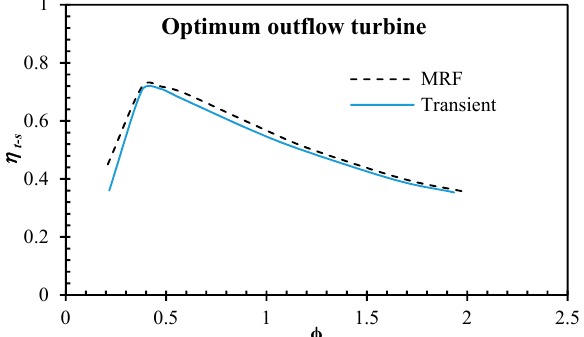
Figure 24. Comparison of efficiency of the optimum outflow turbine using MRF model (Case 1) and the transient model (Case 3). (Vertical axis: total-to-static efficiency, Horizontal axis: flow coefficient).